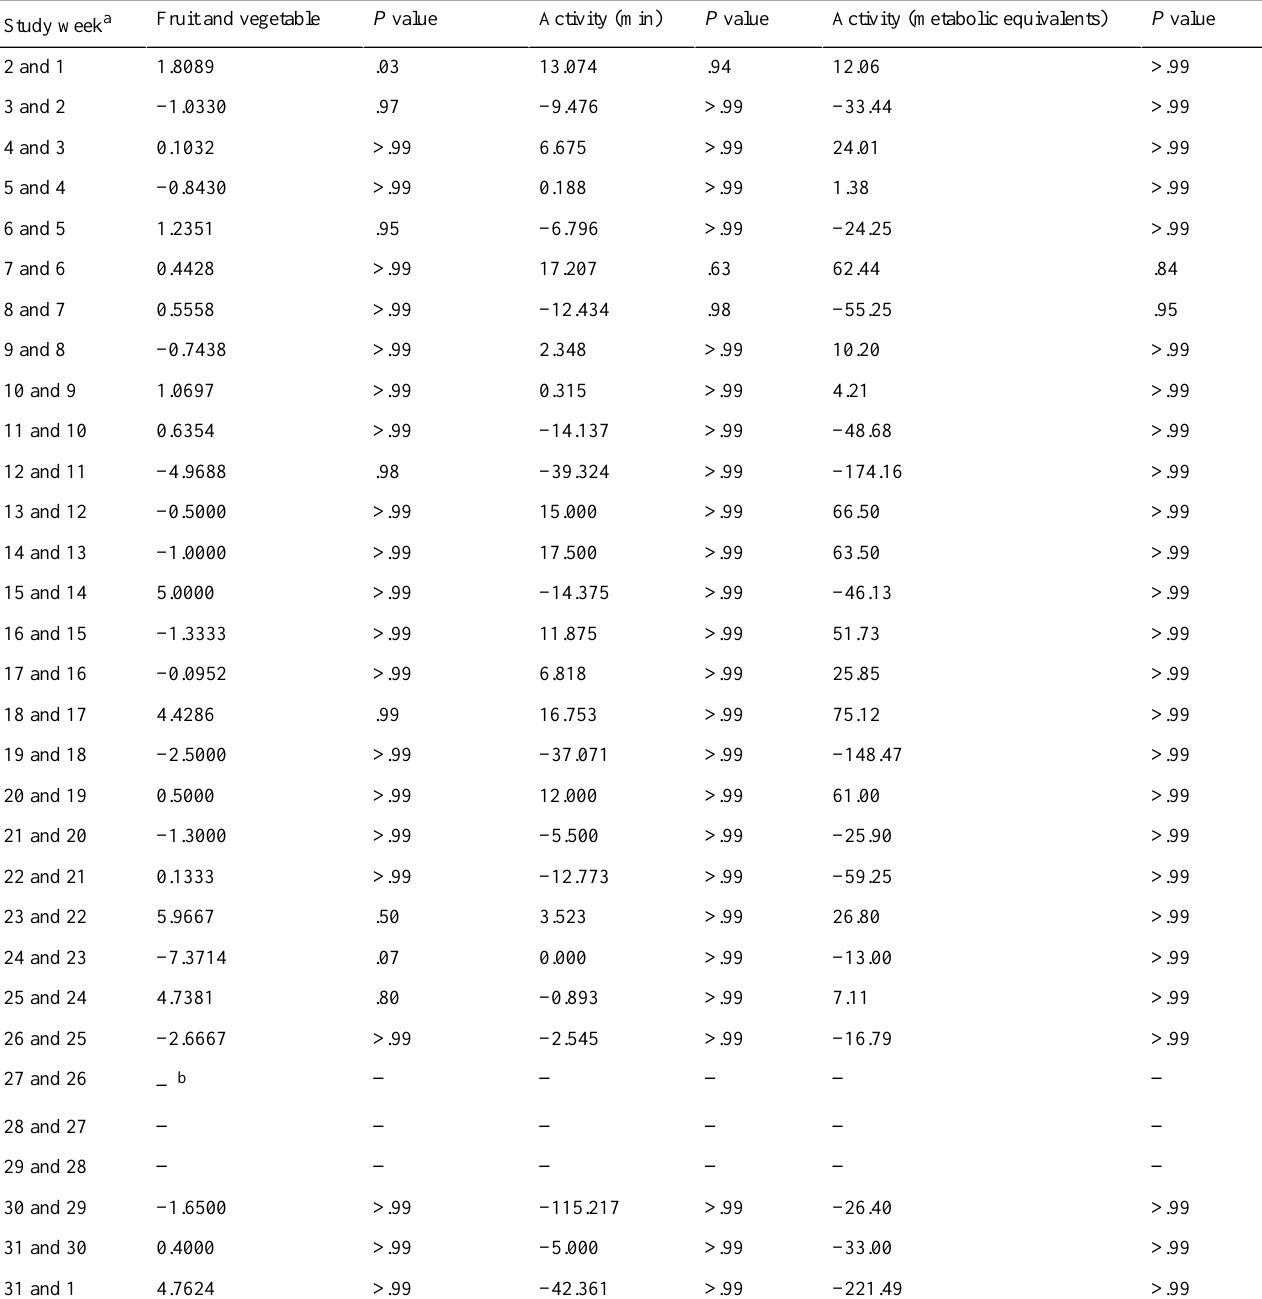
Table 6. Trend of fruit and vegetable and activity results over